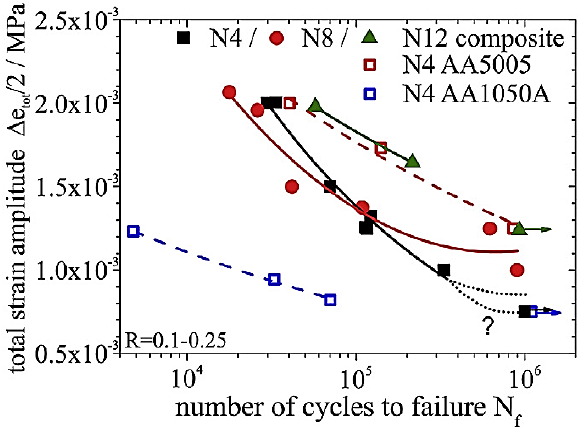
Figure 21. Total strain fatigue life diagram of the composites processed by different numbers of ARB cycles, ARB processed AA1050A and AA5005 mono-material sheets [137].